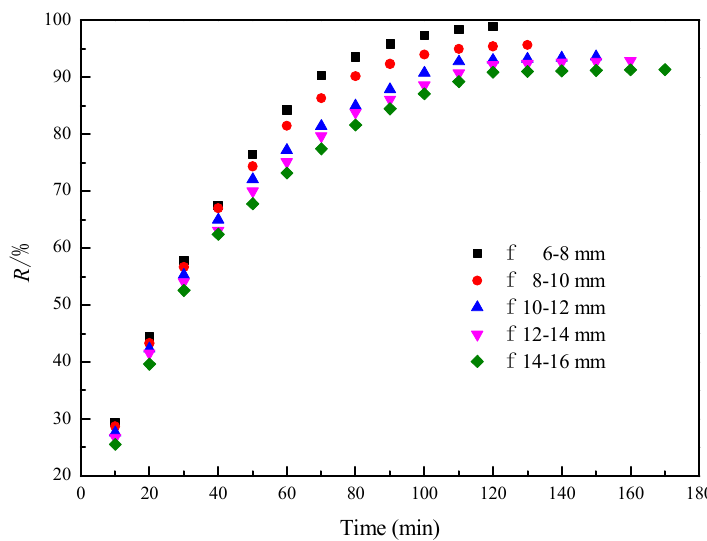
Figure 10. The reduction degree curves of oxidized VTM pellets at 1273 K with different oxidized VTM pellets diameter in H 2 /(H 2 + CO) = 1/2 atmosphere.